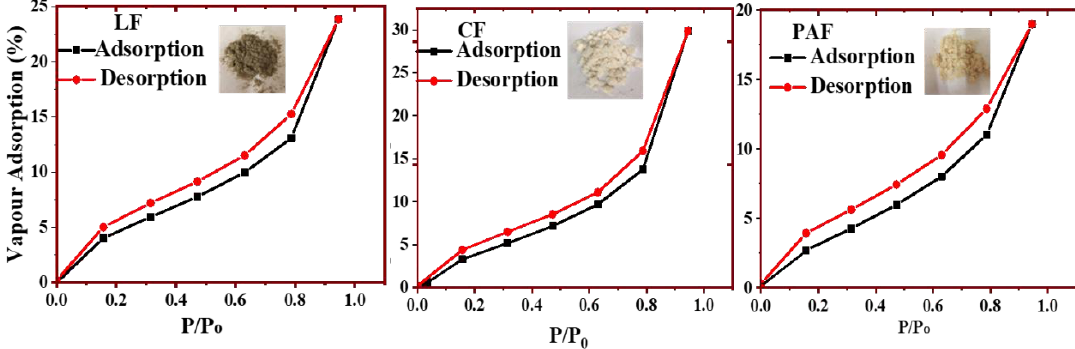
Figure 6. Water vapour adsorption isotherms at 25 °C for linen fiber (LF), and its treated chlorite- (CF) and perchloroacetic acid- (PAF) treated forms.